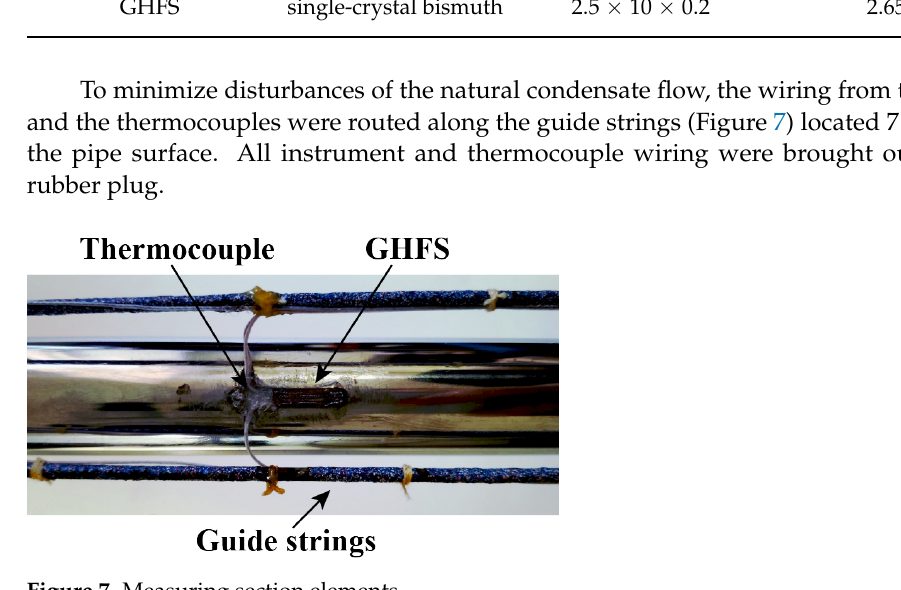
Figure 7. Measuring section